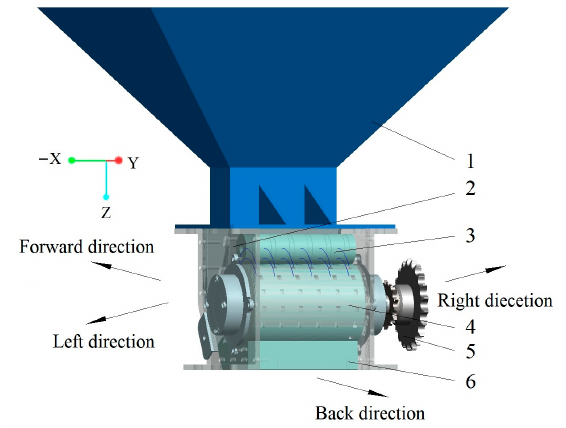
Figure 1. The 3D model of a centralized seed-metering device for rapeseed. Note: (1) seed box, (2) shell, (3) seed-cleaning brush, (4) seed-metering mechanism, (5) transmission mechanism, (6) seed outlet. The forward and back directions were the forward and back directions in the view of the seeder, respectively. The left and right directions were from the view of the back direction. The X direction, Y direction, and Z direction were directions from left to right, directions from forward to back, and direction of gravity, respectively. The same is true elsewhere.